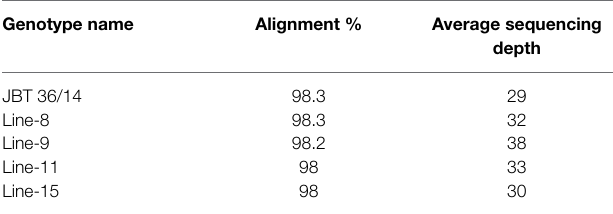
TABLE 2 | Alignment of HQ reads on reference genome and average sequencing depth of each line in this study. Genotype